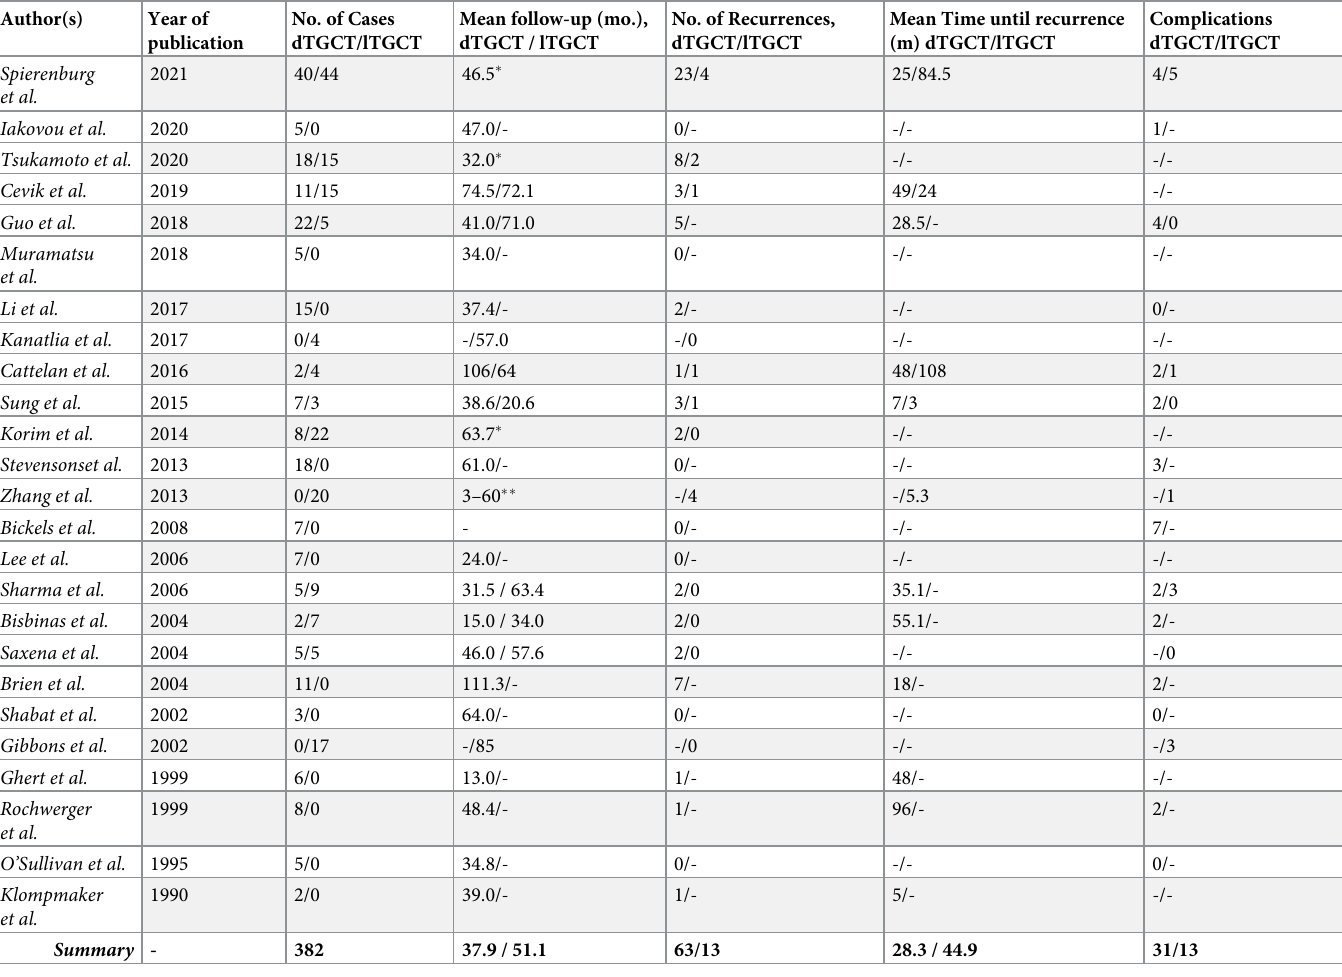
Table 2. Follow-up, recurrences, time to recurrence and complications.